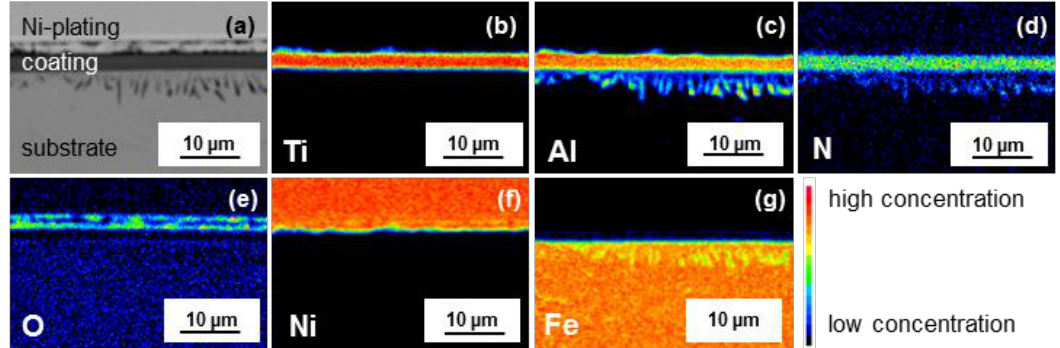
Figure 6. Scanning electron microscope image ( a ) and electron probe micro analysis (EPMA) scans of the cross-section after oxidation for 100 h at 700 ◦ C for Ti ( b ), Al ( c ), N ( d ), O ( e ), Ni ( f ) and Fe ( g ).